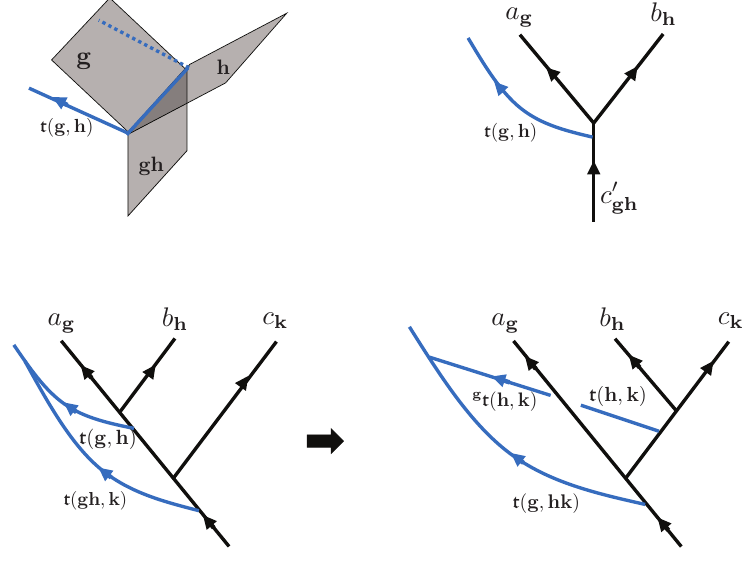
Figure 2: Top left: Fusion of defect branch sheets. Changing the symmetry fraction- alization class by a 2-cocyle t ( g , h ) changes the fusion of the defect worldsheets by the appearance of a Wilson line of t ( g , h ) at the trijunction. Top right: Equivalent diagrammatic representation, where a , b are the end-points of the g and h line de- ∑ g h (cid:2) b = t ( g , h ) fects. The fusion rule of the new theory thus becomes a N c c . g h gh c gh ab = t ( g , h ) c We define c ′ . Bottom panel: associativity of the defect fusion implies gh gh the 2-cocyle condition for t ( g , h ) .